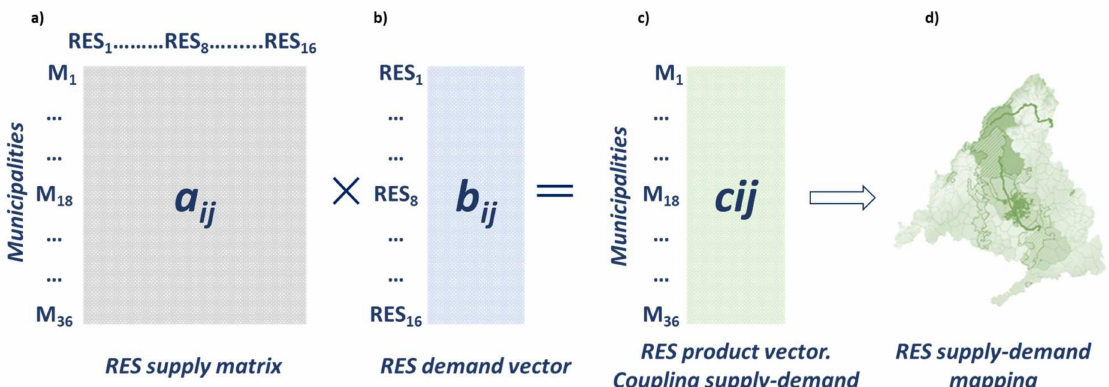
Figure 4. Scheme of the matrix algebra procedure followed to quantify the spatial correspondence between the supply and demand for RES. ( a ) matrix elements aij represent the supply values of RES (RES1-RES16) in each municipality (M1-M36); ( b ) vector elements bji are the demand values of RES, obtained from the calculation of the frequencies of response of the visitors to the survey questions; ( c ) output vector elements cij, obtained from a matrix-vector product, quantify the degree of coupling between the supply and demand for RES; ( d ) mapping the degree of coupling between supply and demand for RES.